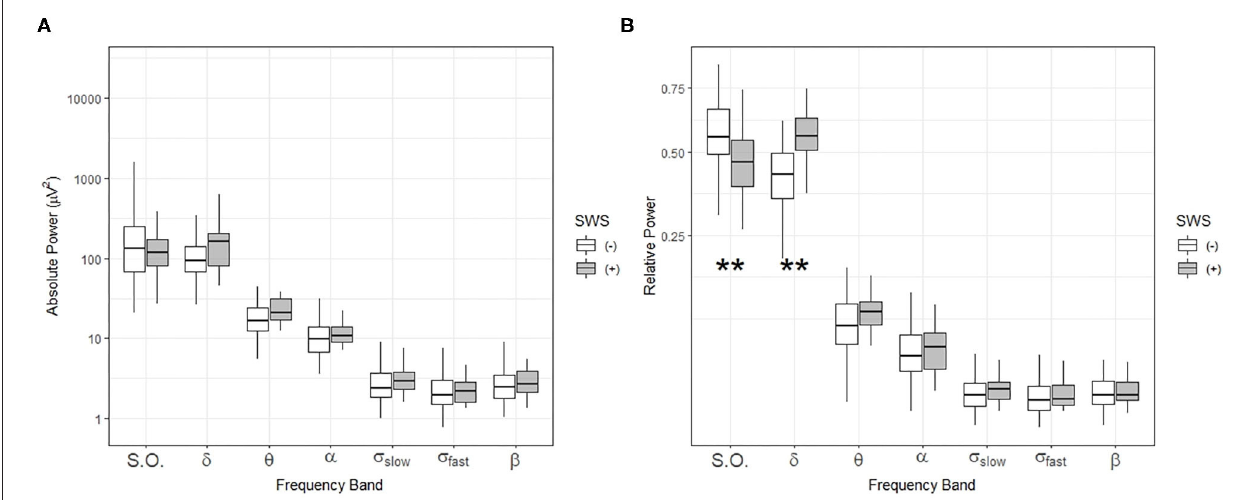
FIGURE 4 | Comparisons of sleep-related frequency bands during NREM sleep in the first ultradian cycle (88.5min) in individuals with ( + ) and without (–) slow-wave sleep (SWS). Box-and-whisker plot of absolute power (A) and relative power (B) during the first 88.5min of sleep. SWS ( + ): participants with slow wave sleep, SWS (–): participants without slow wave sleep. Centerline, median; box limits, upper and lower quartiles; whiskers, 1.5x interquartile range. S.O.: slow oscillation (0.5–1Hz), δ : delta (1–4Hz), θ : theta (4–8Hz), α : alpha (8–12Hz), σ slow : slow sigma (12–13.5Hz), σ fast : fast sigma: (13.5–15Hz), β : beta: (15–20Hz). ** p < 0.01 by t -test.